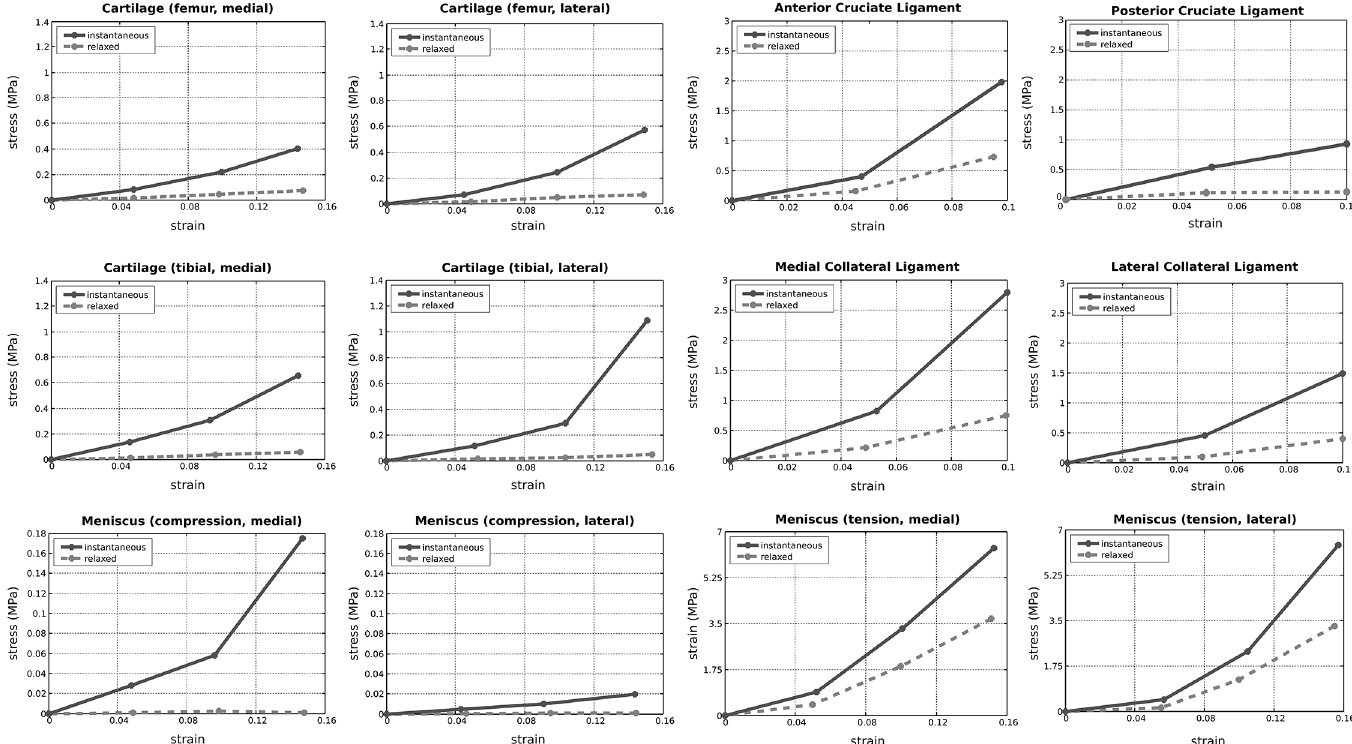
Fig 8. Reconstructed stress-strain response of all tissues at target strain levels, for instantaneous and relaxed states. Nominal stresses and grip-to- grip strains are reported. For estimates of moduli, refer to Table 2. The posterior cruciate ligament failed during the second ramp loading (10% strain); this describes the unexpected decrease in the stiffness of this tissue for larger strains. At the relaxed state, the stress response of the menisci during compression was low; the values reported may potentially be hindered by experimentation